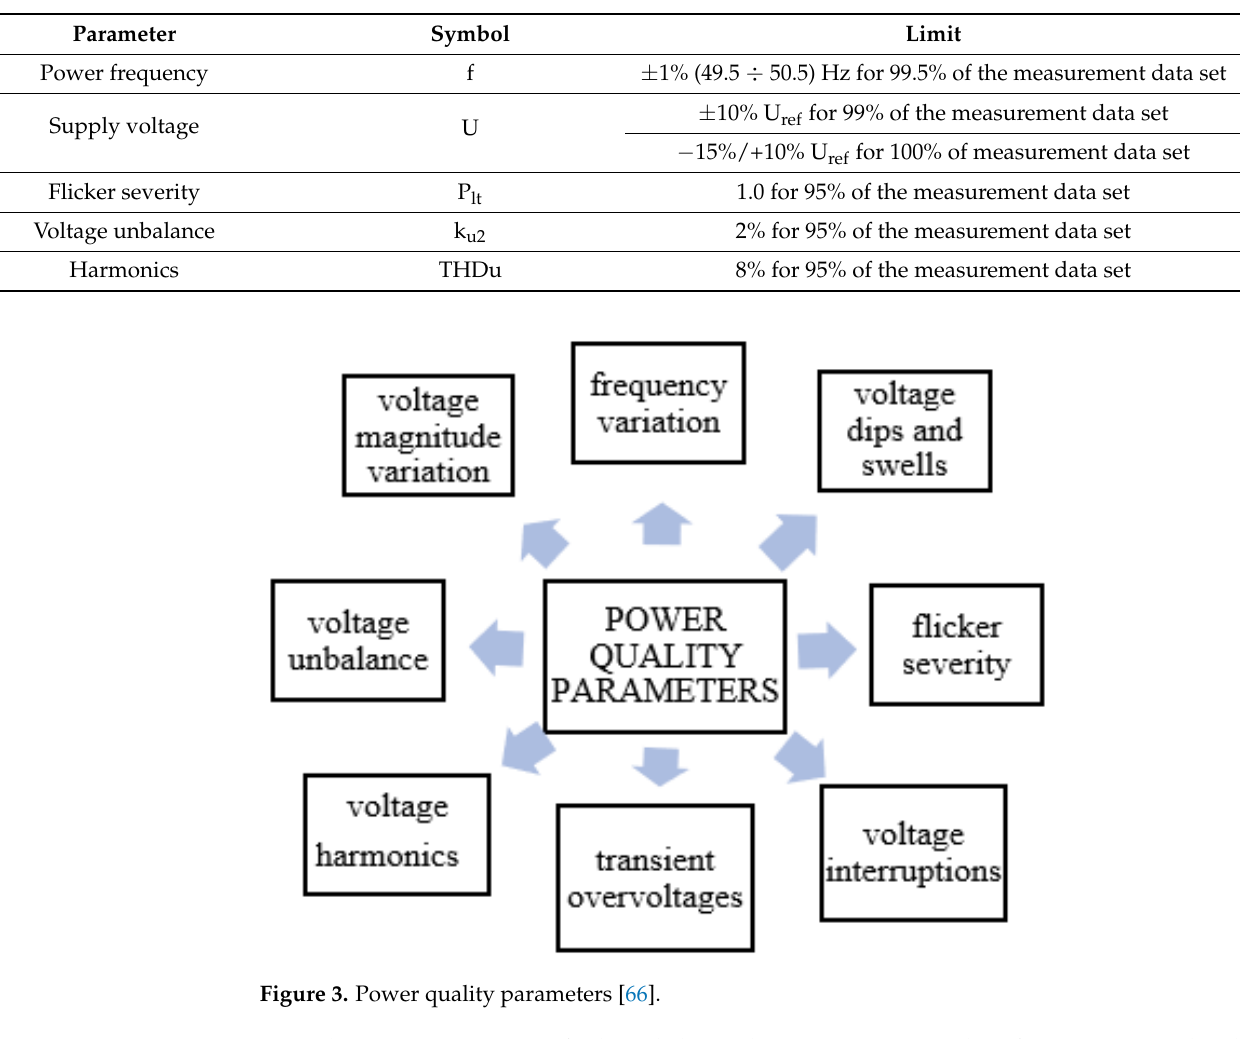
Table 1. Requirements regarding power quality in the low-voltage grid according to EN 50160 standard [66].